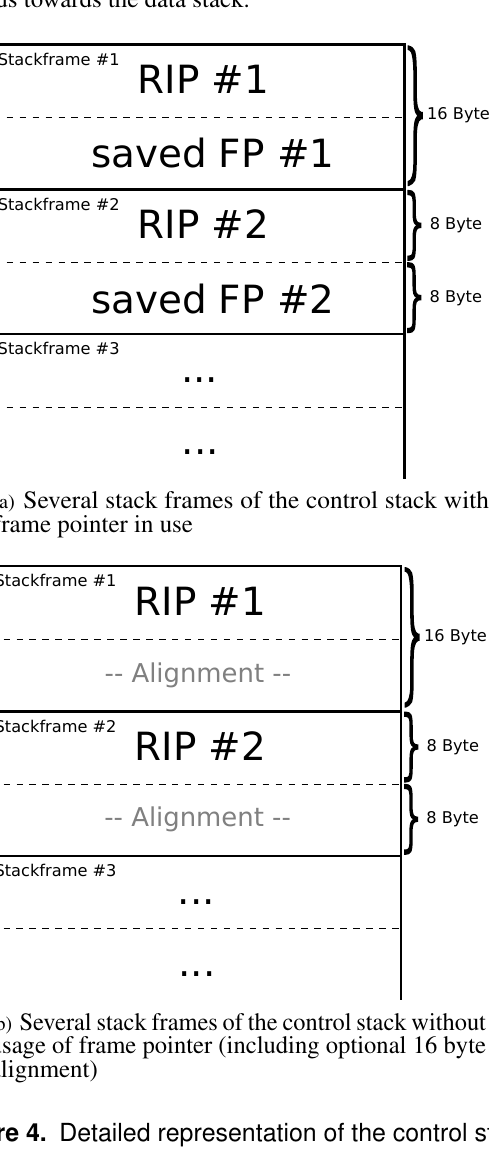
Figure 4. Detailed representation of the control